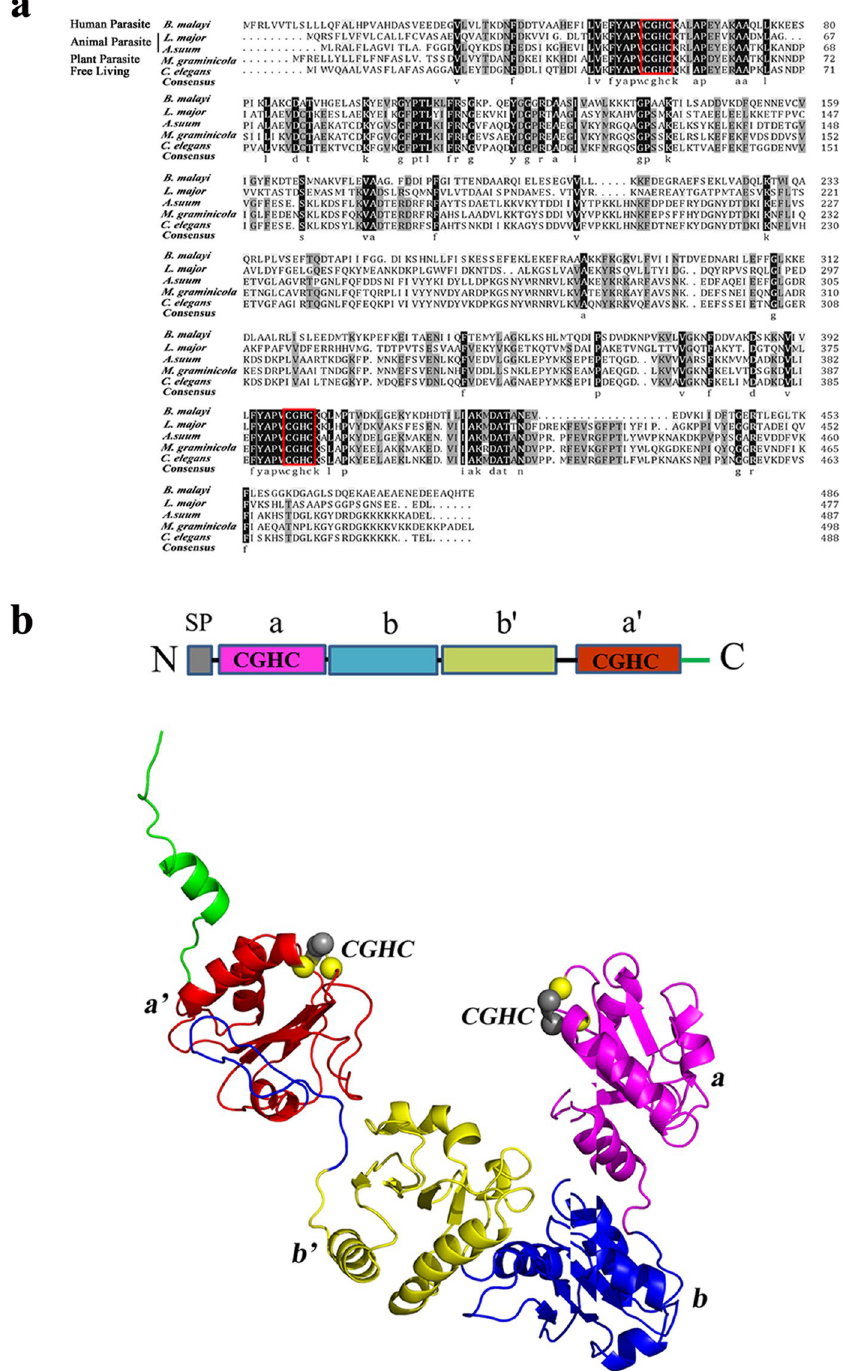
Figure 1. Sequence and structural analysis of MgPDI. ( a ) Alignment of MgPDI with orthologues in other nematode species. ( b ) Schematic drawing of MgPDI primary and tertiary